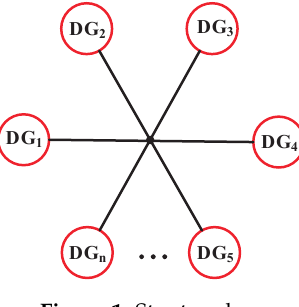
Figure 1. Star topology.